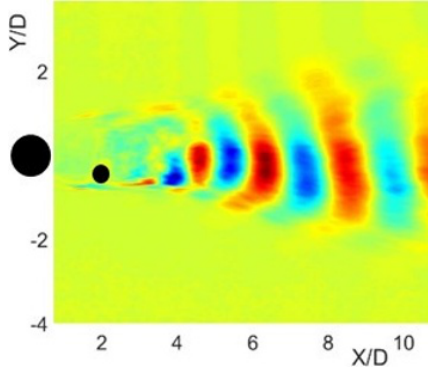
Fig. 7. The third POD mode of position 5